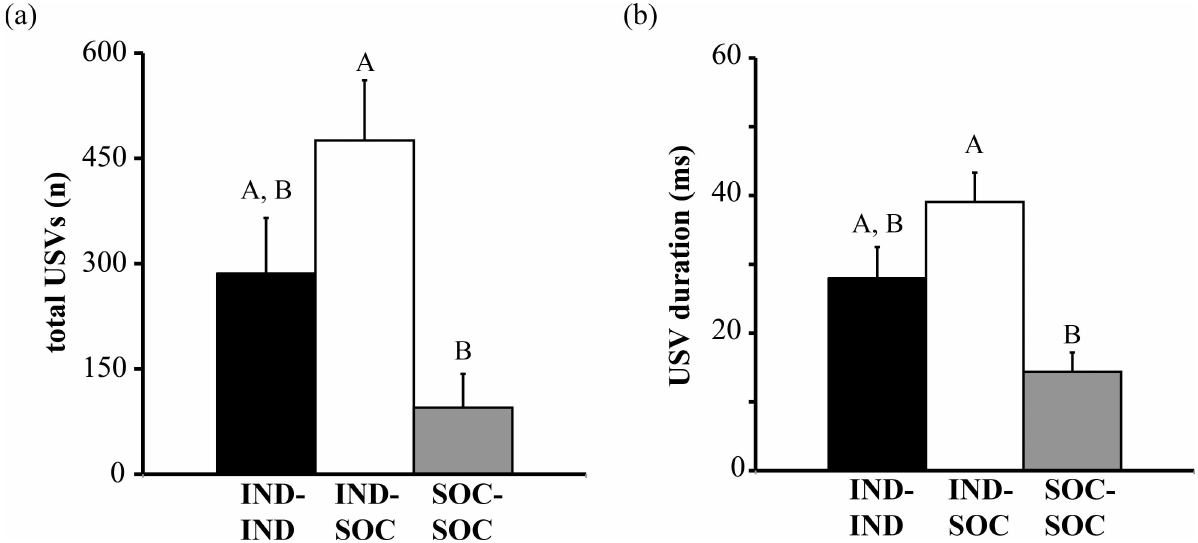
Fig 2. Social history influences the total number and duration of ultrasonic vocalizations (USVs) emitted by male mice. (a) Total numberof USVs emitted by pairs of male mice with different social histories. (b) Mean durationof USVs emitted by pairs of male mice with different social housinghistories. Bar heightsrepresent means ± S.E.M; bars with different letters are statistically different (Kruskal-Wallis tests with Bonferroni post-hoc tests, p < 0.05). IND = individuallyhousedmale; SOC = sociallyhousedmale. See methods for additional